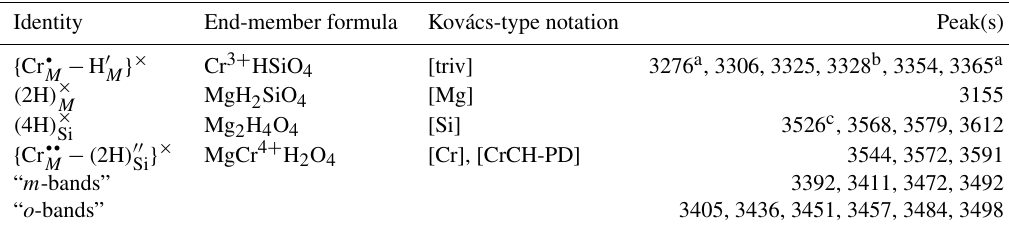
Table 2. Peaks assigned to the different defects, or groups, described and justified in the discussion. These are given in Kröger–Vink notation by the end-member formula and in the commonly used square bracket shorthand notation based on Kovács et al. (2010). { Cr is notated both as [Cr], i.e. the Cr version of the Kovács et al. (2010) [Ti] defect, and [CrCH-PD], i.e. the Cr version of the Jollands et al. (2016b) [TiCH-PD]. This notation is given for reference and comparison only and is not used in this text. The “ m -bands” show humped (rim-to-core) or M-shaped (rim-to-rim) profiles. These are described using a lower-case, italic m to avoid confusion with the M -vacancy mechanism. “ o -bands” describe the broad group “other”.